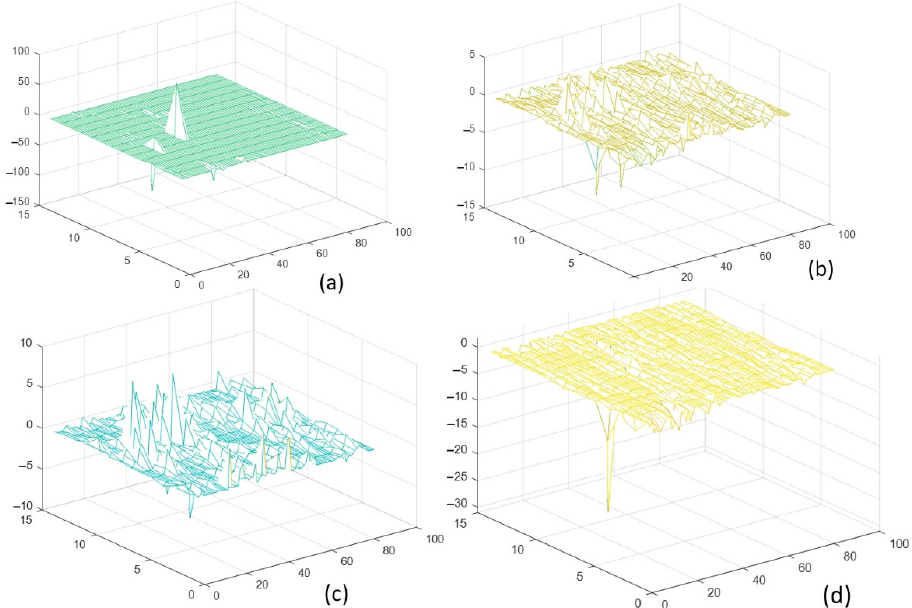
Figure 8. Sym 2 wavelet from the first decomposition level combined with curvature-based method: ( a ) A - K , ( b ) A - H , ( c ) A - X , and ( d ) A - N